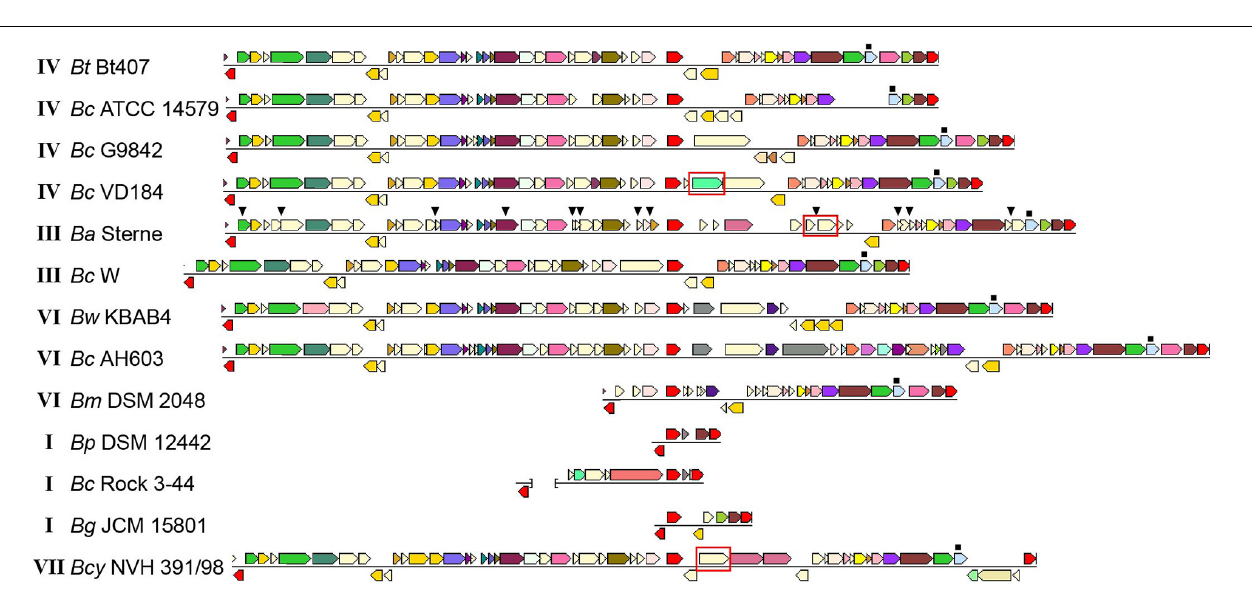
FIGURE 2 | Comparison of motility gene loci in selected Bacillus cereus group strains. Loci from different strains are aligned with respect to mogR , shown in red in the central part of the alignment. For each strain, the first and last gene (shown in red) are conserved genes outside of the motility gene locus itself (orthologs to BTB_RS08235 and BTB_RS08480, respectively). These are included to indicate that the flanking regions and location of the motility locus are generally conserved between strains. The last gene of the intact locus with a predicted function mapping within motility, flgG (light blue), is indicated by a filled square above the gene. For genes shown in a color other than red, identical color indicates that genes are from the same orthologous group (top COG hit), except light yellow which indicates no COG assignment. The gmaR gene is indicated with a red box. In the B. anthracis strain, the filled triangles above genes indicate the location of nonsense or frameshift mutations. The brackets in the representation of the Bc Rock 3-44 sequence indicates that this locus is split between two contigs. Roman numerals next to the strain names indicate the phylogenetic subgroup within the B. cereus group to which the strain belongs (Guinebretière et al., 2008). Bm Rock 1-4, Bm Rock 3-17, Bm 219298 og Bp DSM 12442 from subgroup I had indentical loci; only Bp DSM 12442 is shown. The figure was assembled from images obtained from the Conserved Neighborhood Viewer of the Integrated Microbial Genomes system (Markowitz et al., 2010), using B. thuringiensis 407 proteins BTB_RS08235, BTB_RS08390 ( mogR ), and BTB_RS08480 as query sequences. Abbreviations: Bc , B. cereus ; Bt , B. thuringiensis ; Ba , B. anthracis ; Bw , B. weihenstephanensis ; Bm , B. mycoides ; Bp , B. pseudomycoides ; Bcy , B. cytotoxicus ; Bg , Bacillus gaemokensis